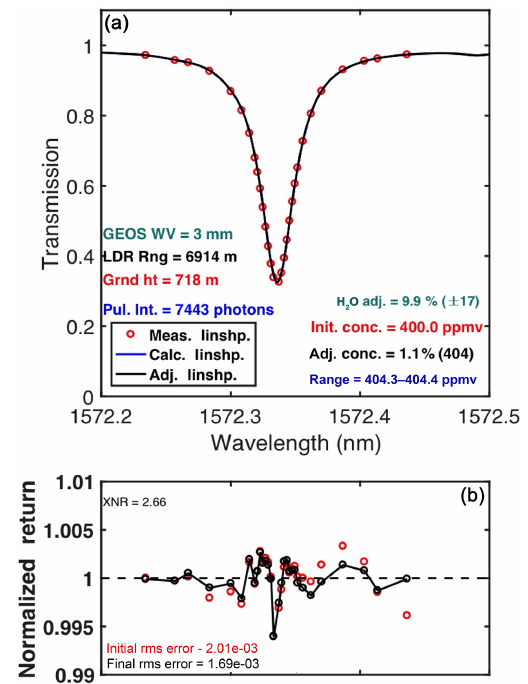
Figure 9. (a) Example of the CO 2 transmission line shape measured by the lidar from an altitude of 7.6km. The line shape samples from the lidar are the red dots. The line shape computed from the retrieval is shown as the black line. (b) The ratio of the retrieved line shape and lidar retrievals with the red dots being the initial trial XCO 2 value of 400ppm and the black dots and line being the final best-fit retrieved XCO 2 value of